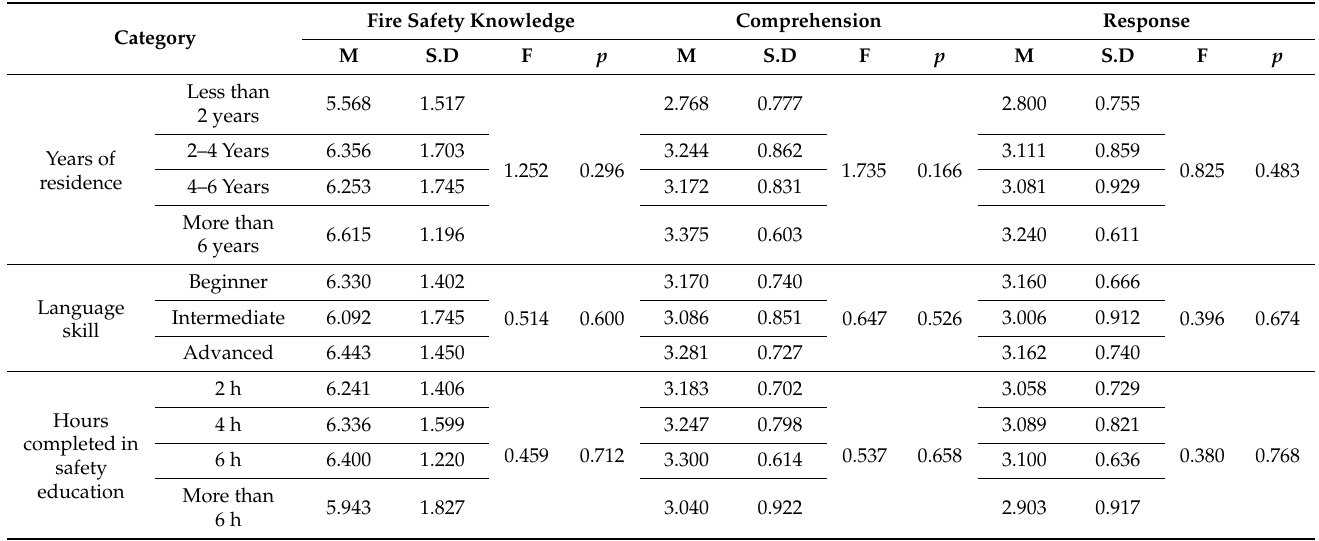
Table 5. Differences in fire safety knowledge, comprehension, and response scores and ANOVA results according to years of residence and language